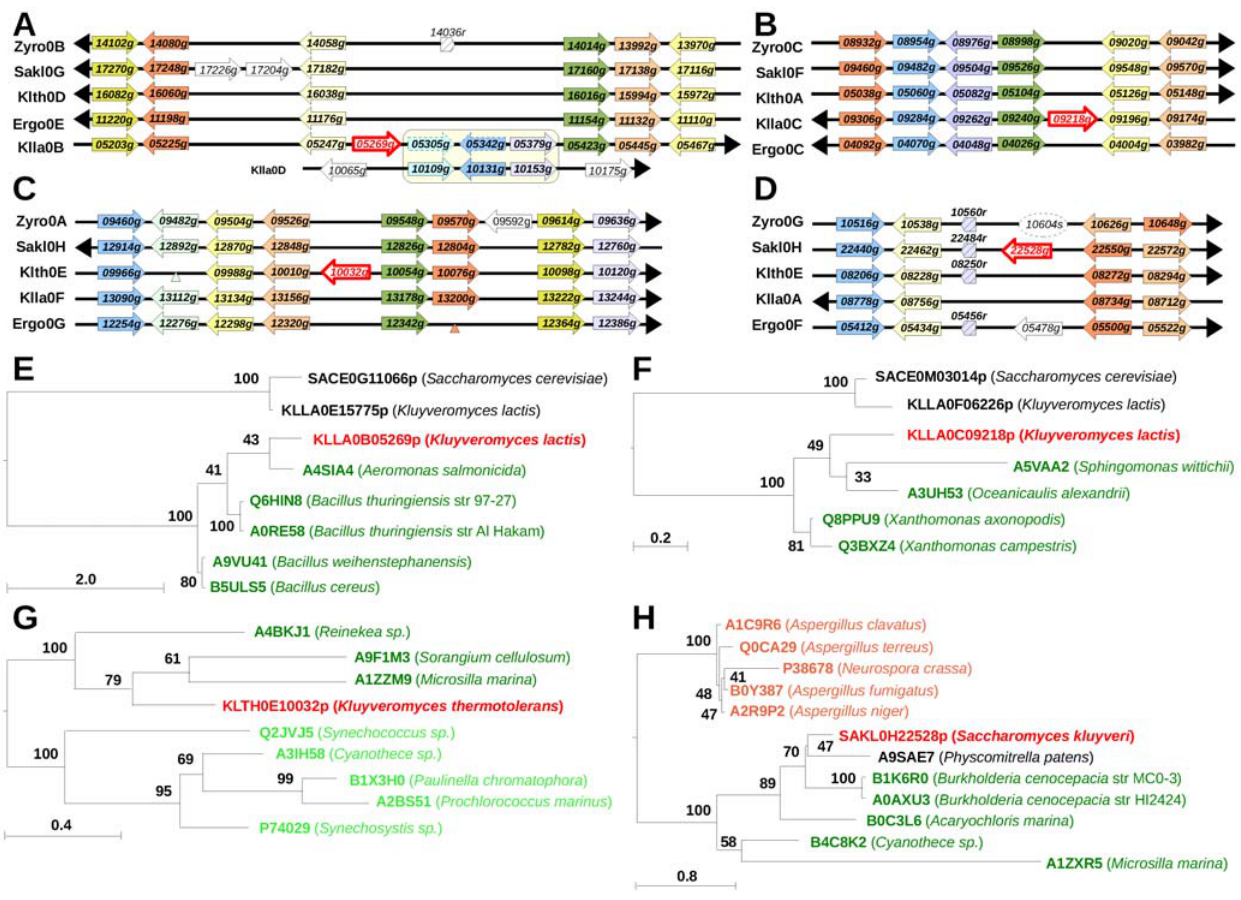
Figure 3. Single HGT candidates in K.lactis , K.thermotolerans and S.kluyveri . (A) Part of the conserved synteny block surrounding the KLLA0B05269g gene (previously reported in [20]). Only protein coding and tRNA genes are shown. Orthologous genes are colored, intervening genes are white, tRNA genes are indicated by short hatched arrows, pseudogenes are identified by dotted lines. Arrows represent gene orientation. The segmental duplication between chromosomes B and D of K. lactis is shown at the bottom of the figure. KLLA0D10109g is similar to S. cerevisiae YOR120W GCY1 , KLLA0D10131g similar to S. cerevisiae YKL221W MCH2, and KLLA0D10153g and KLLA0B05379g are slightly similar to S. cerevisiae YKL222C protein of unknown function. (B) Part of the conserved synteny block surrounding the KLLA0C09218g gene. Same legend as (A). (C) Part of the conserved synteny block surrounding KLTH0E10032g gene. Same legend as (A). Triangles represent single gene species-specific deletions. (D) Part of the conserved synteny block surrounding SAKL0E22528g . Same legend as (A). ZYRO0G10604s is the centromere of chromosome G in Z. rouxii (dotted oval). Note the local inversion of two genes in Z. rouxii . (E) Phylogenetic tree reconstructed from sequence alignment of 81 sites of the KLLA0B05269g product, bacterial proteins (green) and products of S. cerevisiae SMI1 gene and its K. lactis homolog ( YGR229C /SACE0G11066p and KLLA0E15775p, in black). Bootstrap values are indicated next to the nodes and branch length scale is shown at bottom left. (F) Phylogenetic tree reconstructed from sequence alignment of 65 sites of the KLLA0C09218g product, bacterial proteins (green) and the S. cerevisiae glyoxalase I gene ( YML004C /SACE0M03014p) and its K. lactis homolog (KLLA0F06226p). Same legend as (B). (G) Phylogenetic tree reconstructed from sequence alignment of 85 sites of the KLTH0E10032g product and bacterial proteins (dark green, cyanobacteria in light green). Same legend as (B).